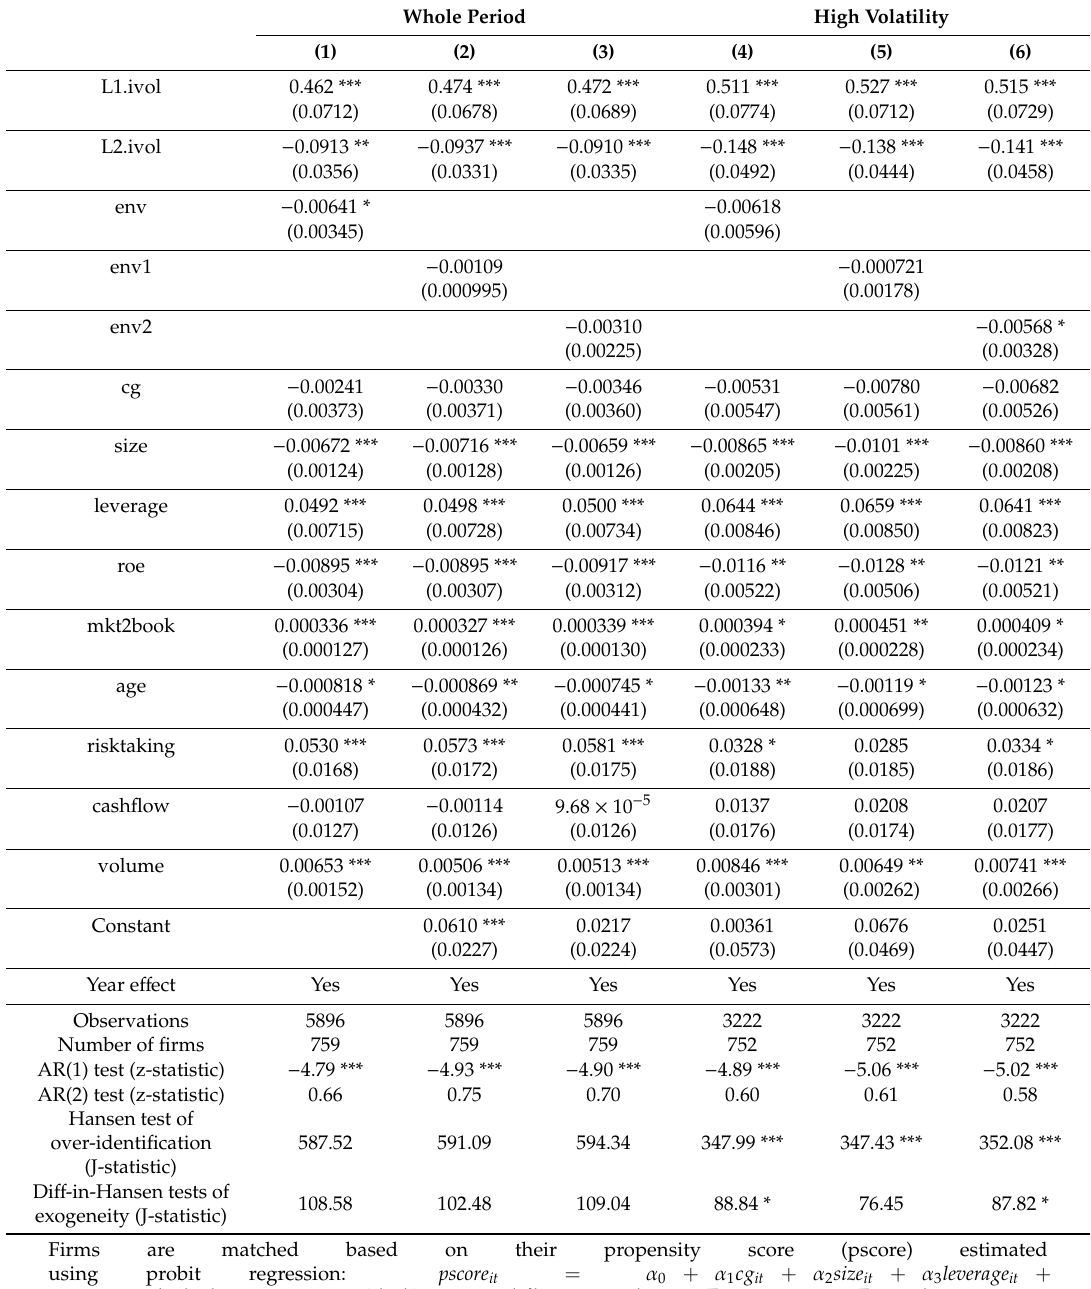
Table 6. Dynamic panel estimation (matched